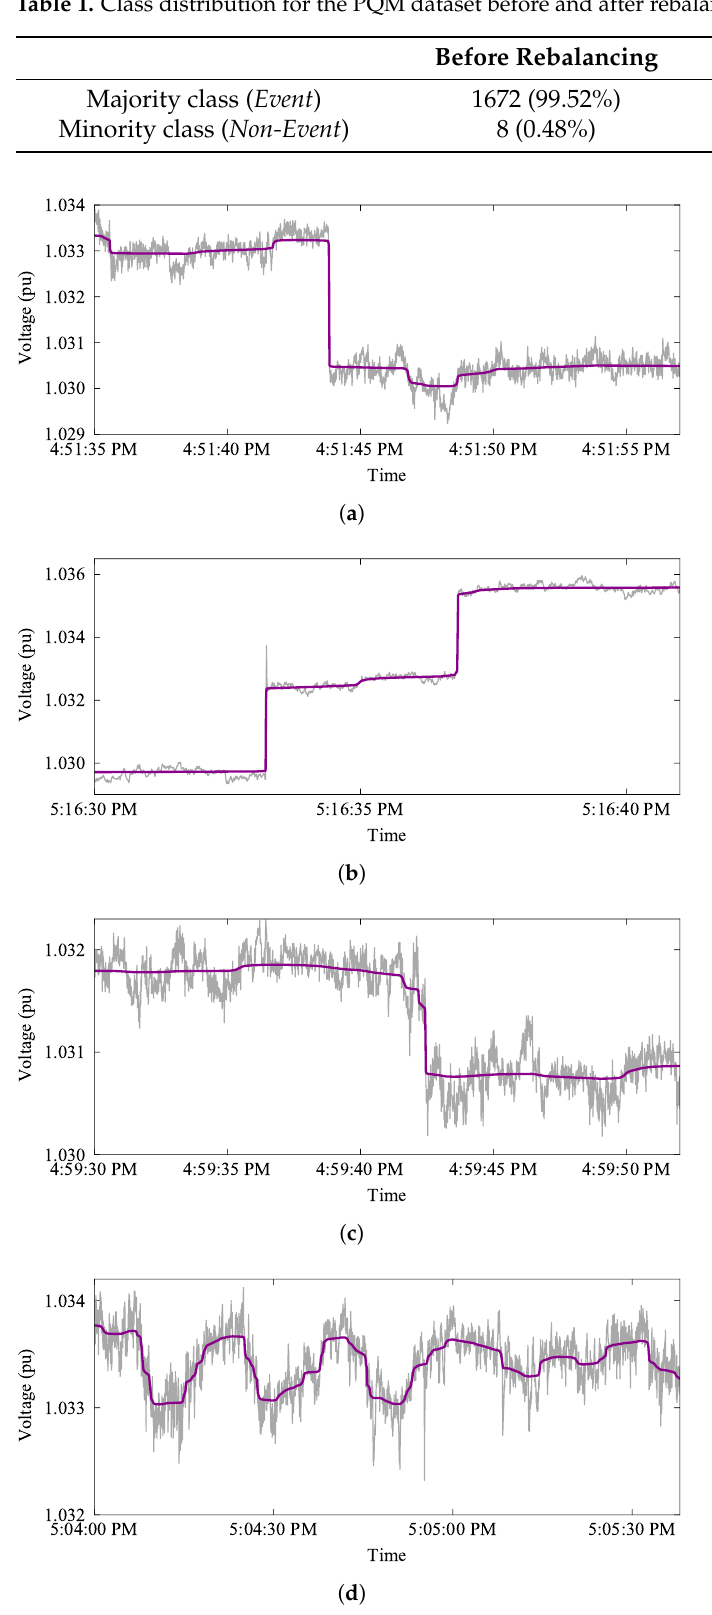
Figure 13. Detailed view of the unfiltered and filtered RMS voltage profiles for the field data. ( a ) Capacitor de-energizing (event 1). ( b ) Successive capacitor energizing (events 7 and 8). ( c ) Load energizing (between events 3 and 4). ( d ) Steady-state (between events 4 and